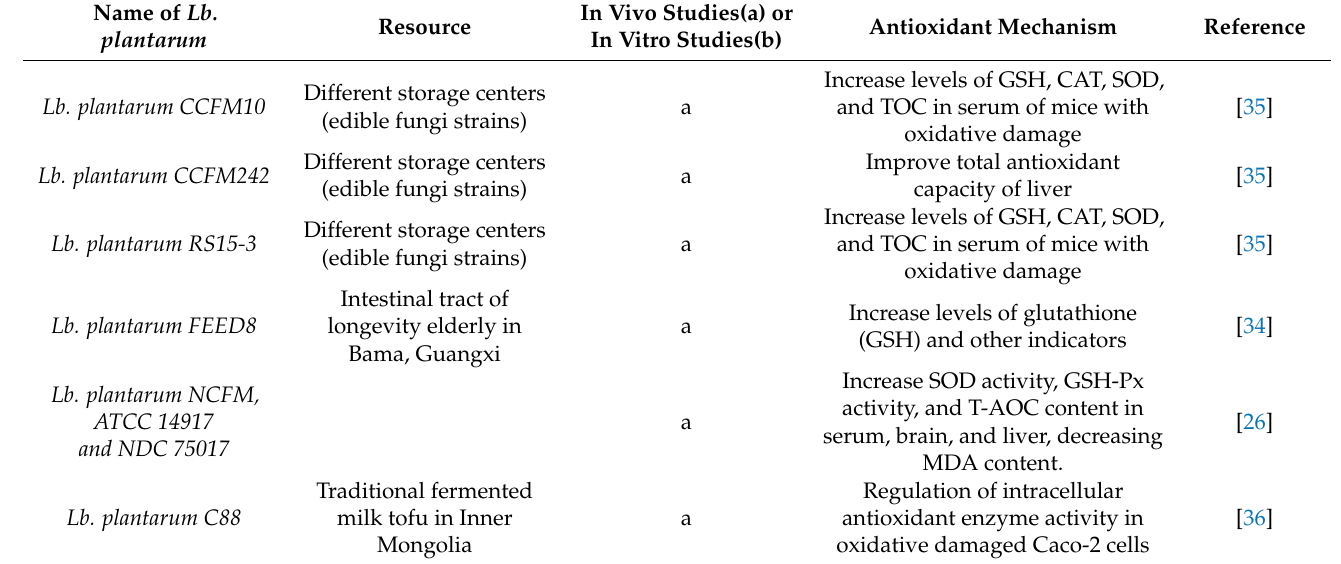
Table 1. Possible mechanisms by which Lb. plantarum protects cells from the attack of free radicals. Name of